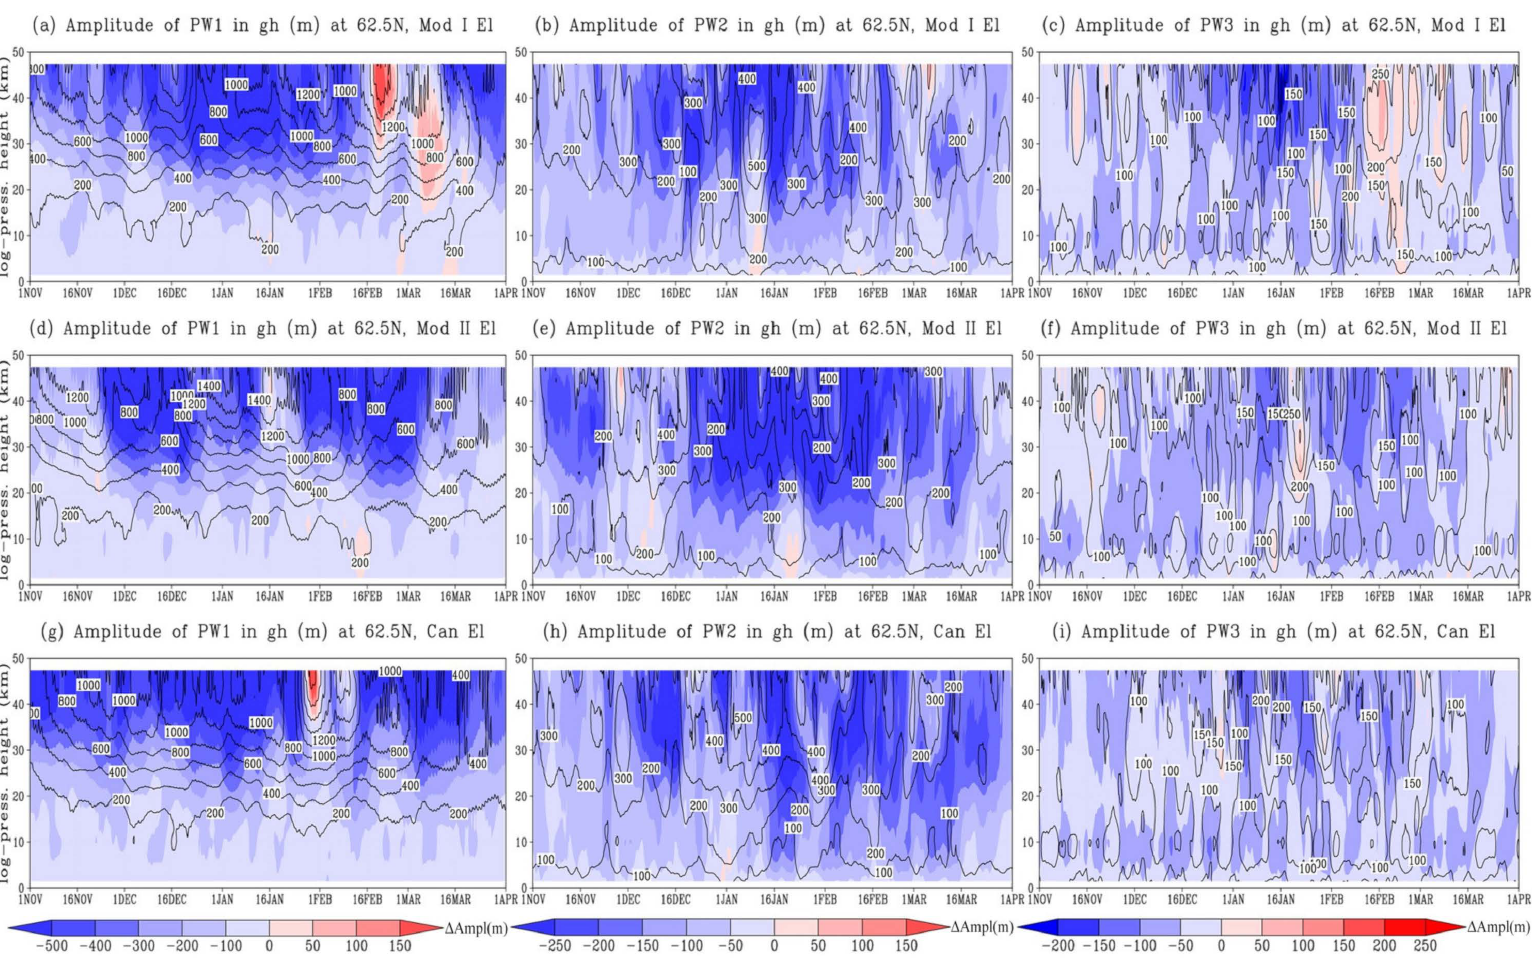
Figure 1. Contours: amplitudes of planetary waves with zonal wavenumber 1 ( left panels ), 2 ( middle panels ), and 3 ( right panels ) in geopotential height (meters) at 62.5 ◦ N during Modoki I conditions ( top panels ), Modoki II conditions ( middle panels ), and canonical conditions ( bottom panels ). Shading: respective anomalies relative to climatic distributions (November–March,